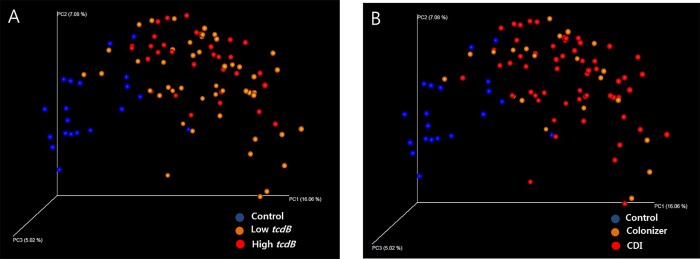
Evaluation of beta-diversity in control (blue) and tcdB positive patients (A, low and high tcdB; B, colonizer and CDI, orange and red, respectively). Principal coordinate analysis (PCoA) was performed using unweighted UniFrac distances of 16S rRNA gene sequences. The each axis represents intersample variation.